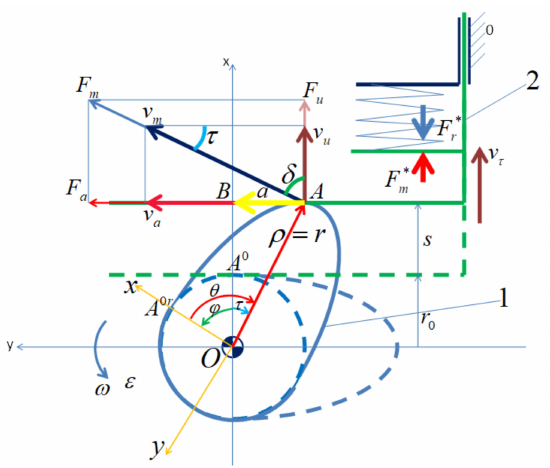
Figure 1. A mechanism with rotary cam and a plate, translated